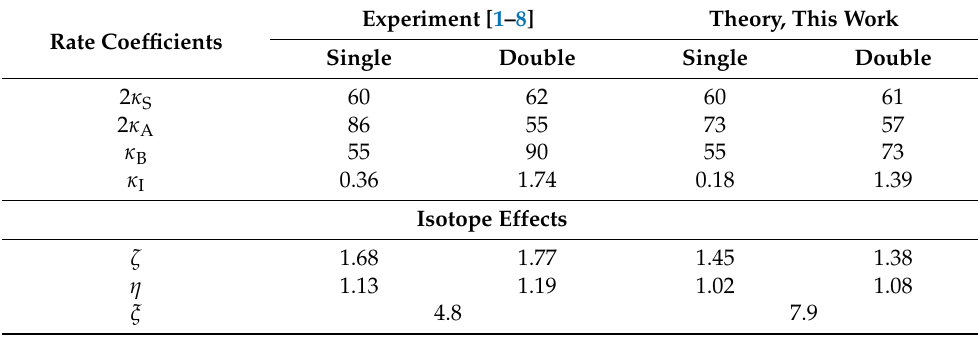
Table 1. Experimental and theoretical rate coefficients (in the units of 10 − 35 cm 6 /s) for four pathways of ozone formation at 296 K in the cases of single and double isotopic substitution, and the corre- sponding three isotope effects as defined by Equations (61), (64)–(67) in Sections 3.1 and 3.2 below. Experiment [1–8] Theory, This Work Rate Coefficients Single Double Single Double 2 κ S 60 62 60 61 2 κ A 86 55 73 57 55 90 55 73 Isotope Effects